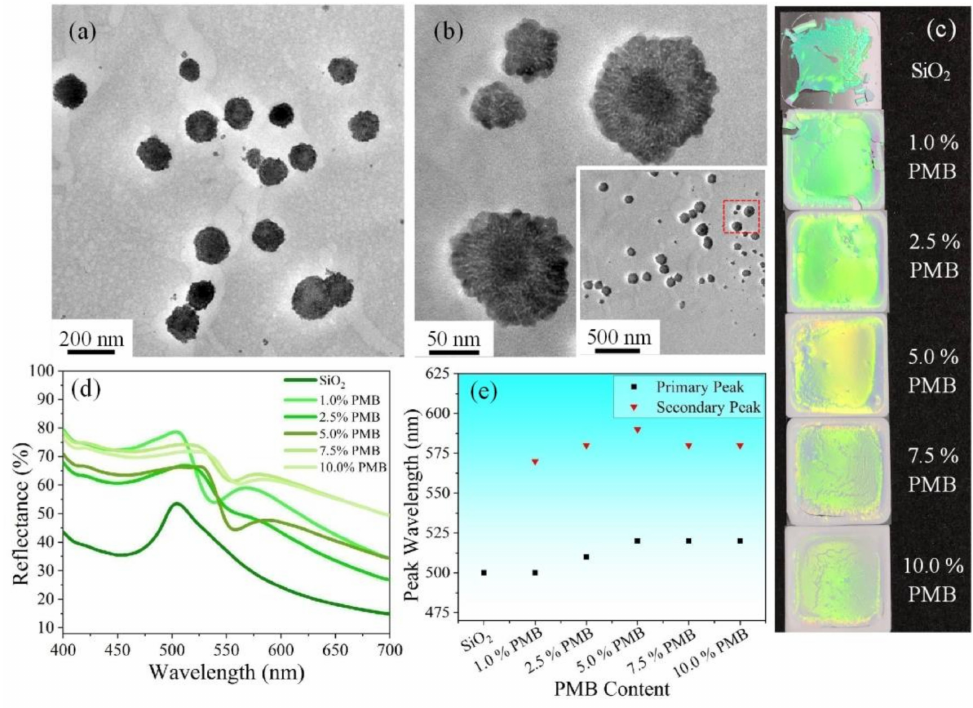
Figure 4. TEM images of poly(methyl methacrylate-butyl acrylate) (PMB) with magnification of ( a ) 12,000 × , ( b ) 50,000 × , inserted zoom-out image: 8000 × . ( c ) Photos of SiO 2 PCFs with different concentrations of PMB on glasses. ( d ) The related reflectance of ( c ). ( e ) The peak photonic bandgap wavelength of ( d